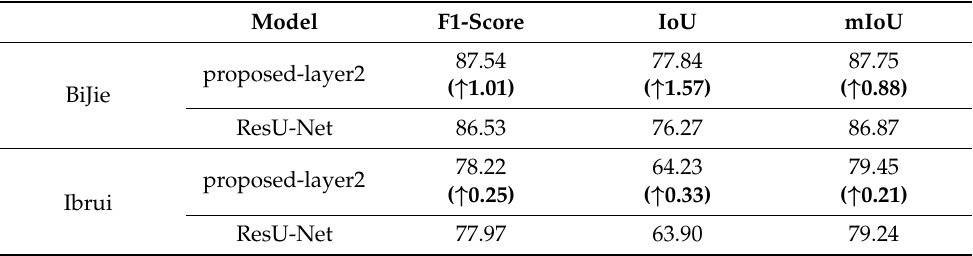
Table 7. The performance of the proposed model with transformer Layer = 2. The bold means the improvement in the proposed